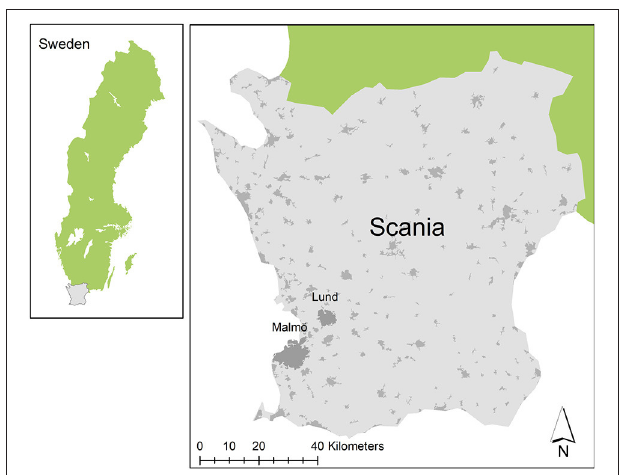
FIGURE 1 | Map of study setting in Scania,